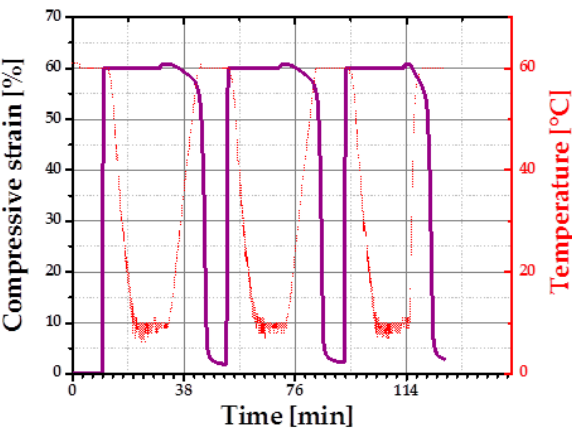
Figure 8. One-way SME for cPCL-2/4/8k-180 (heating and cooling rates were 5 K ∙ min − 1